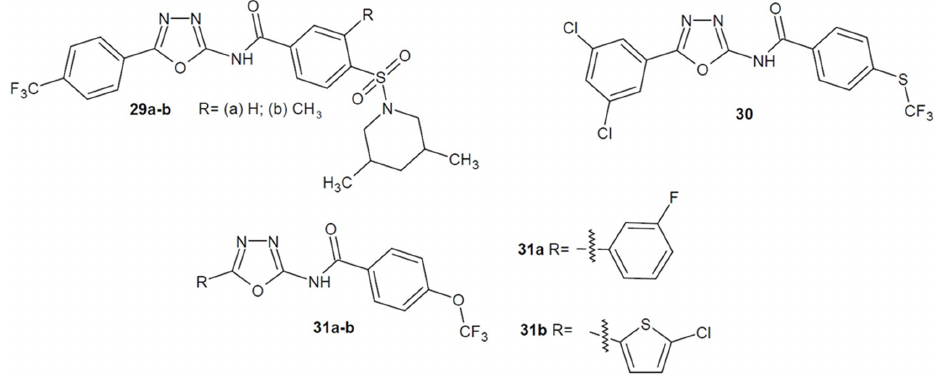
and MRSA strains than vancomycin and was 8 times more active than linezolid. Com-